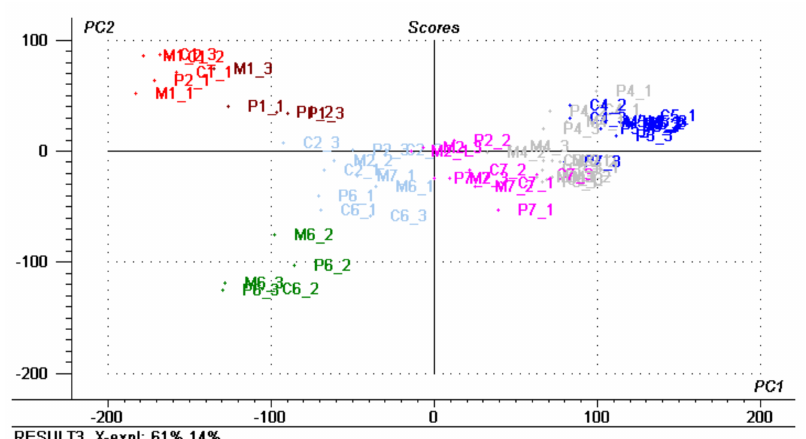
Figure 4. PCA scope plot of P. tricornutum (P) Contaminant (C), and Mix(M) growth over 22 days period. The colors correspond to the different clusters assigned with CA, namely: blue–class 1, red–class 2; green–class 3; light blue–class 4, brown–class 5; grey–class 6; pink–class